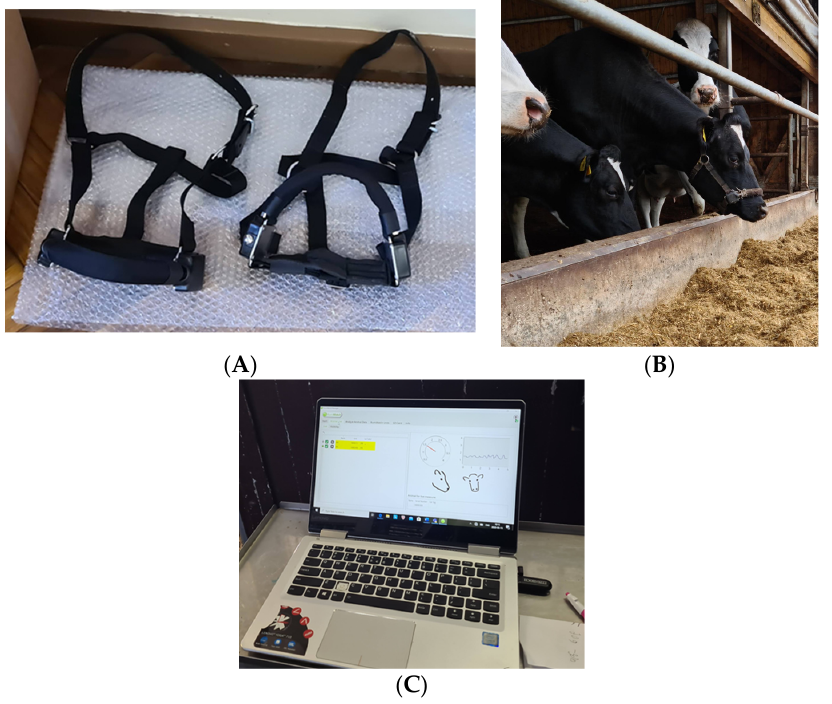
Figure 1. Measurement and data analyses: ( A ) RumiWatch sensors (RWS); ( B ) cows with RWS; ( C ) data visualization and analysis.